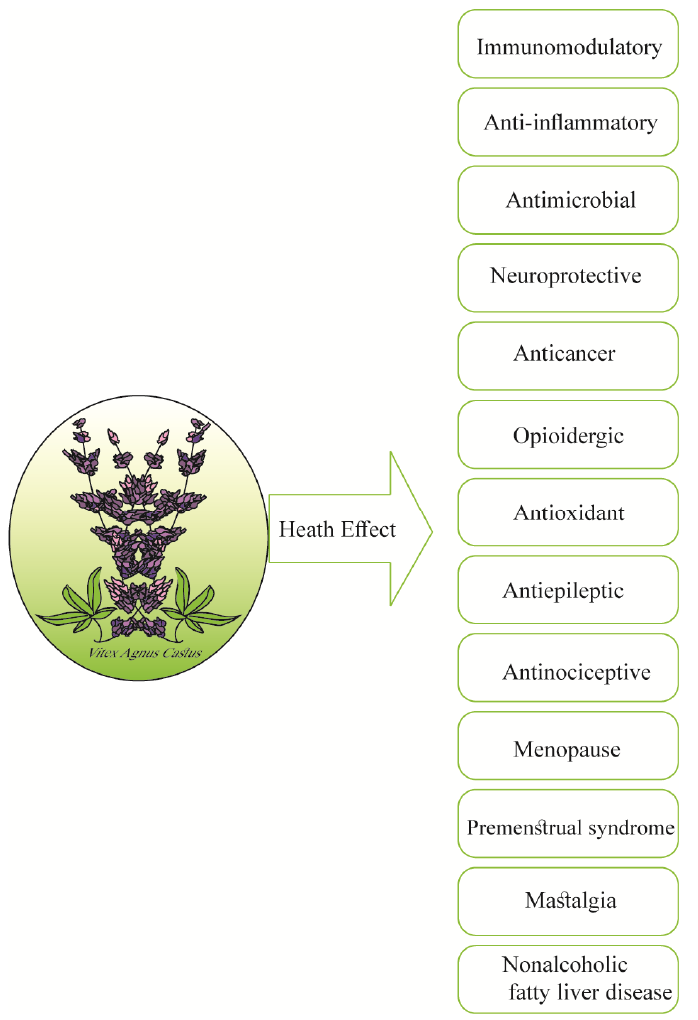
Figure 1. Scheme of the beneficial properties of Vitex agnus-castus L.